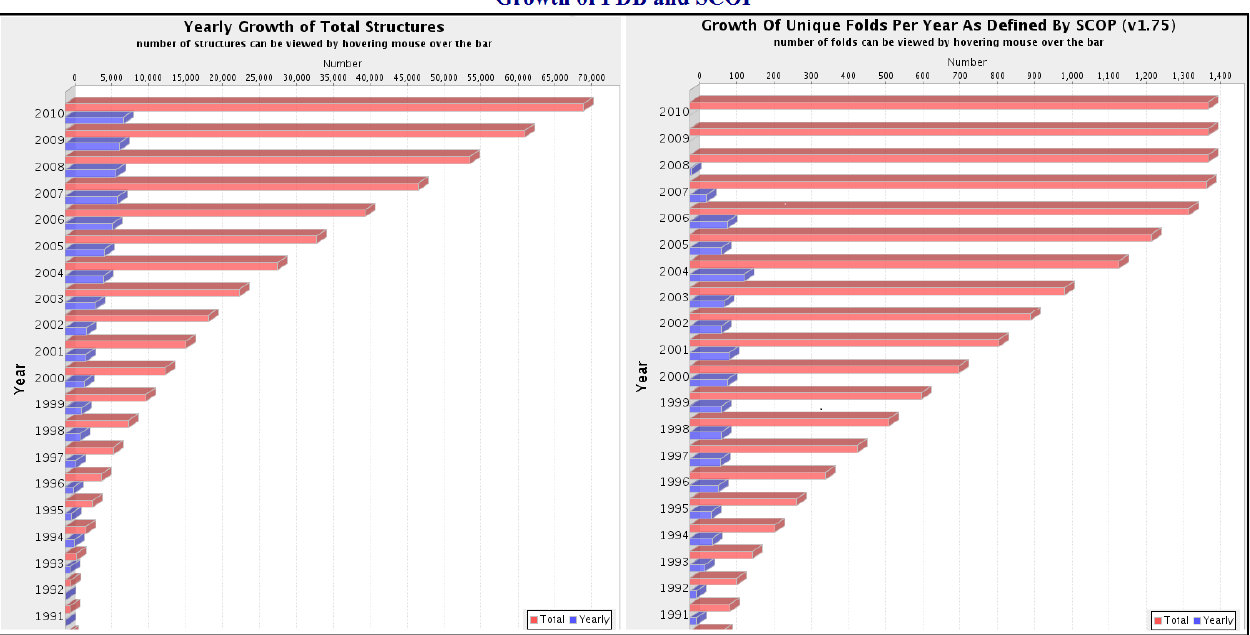
Figure 7. Growth of PDB and SCOP [9].